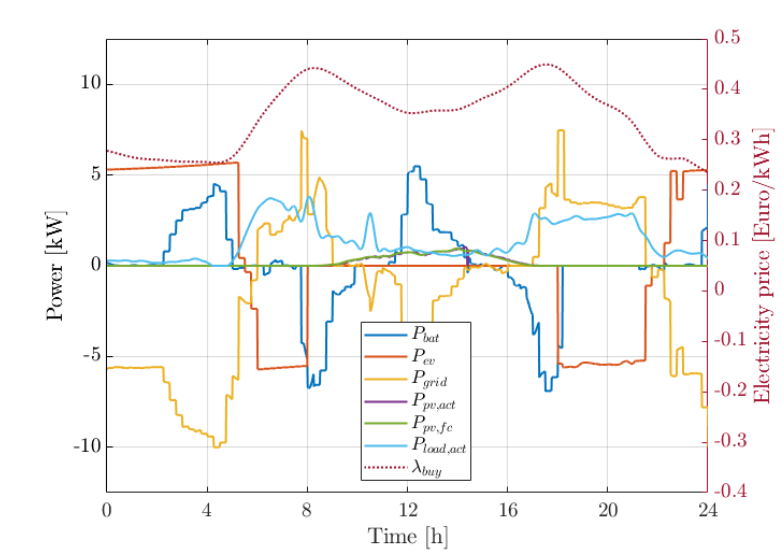
Figure 10. (left axis:) Optimized power flows for a winter day and (right axis:) energy buying price.